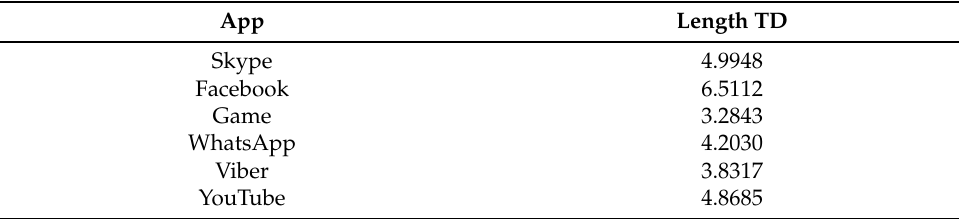
Table 15. Length traffic divergence TD between original and mutated traffic, using